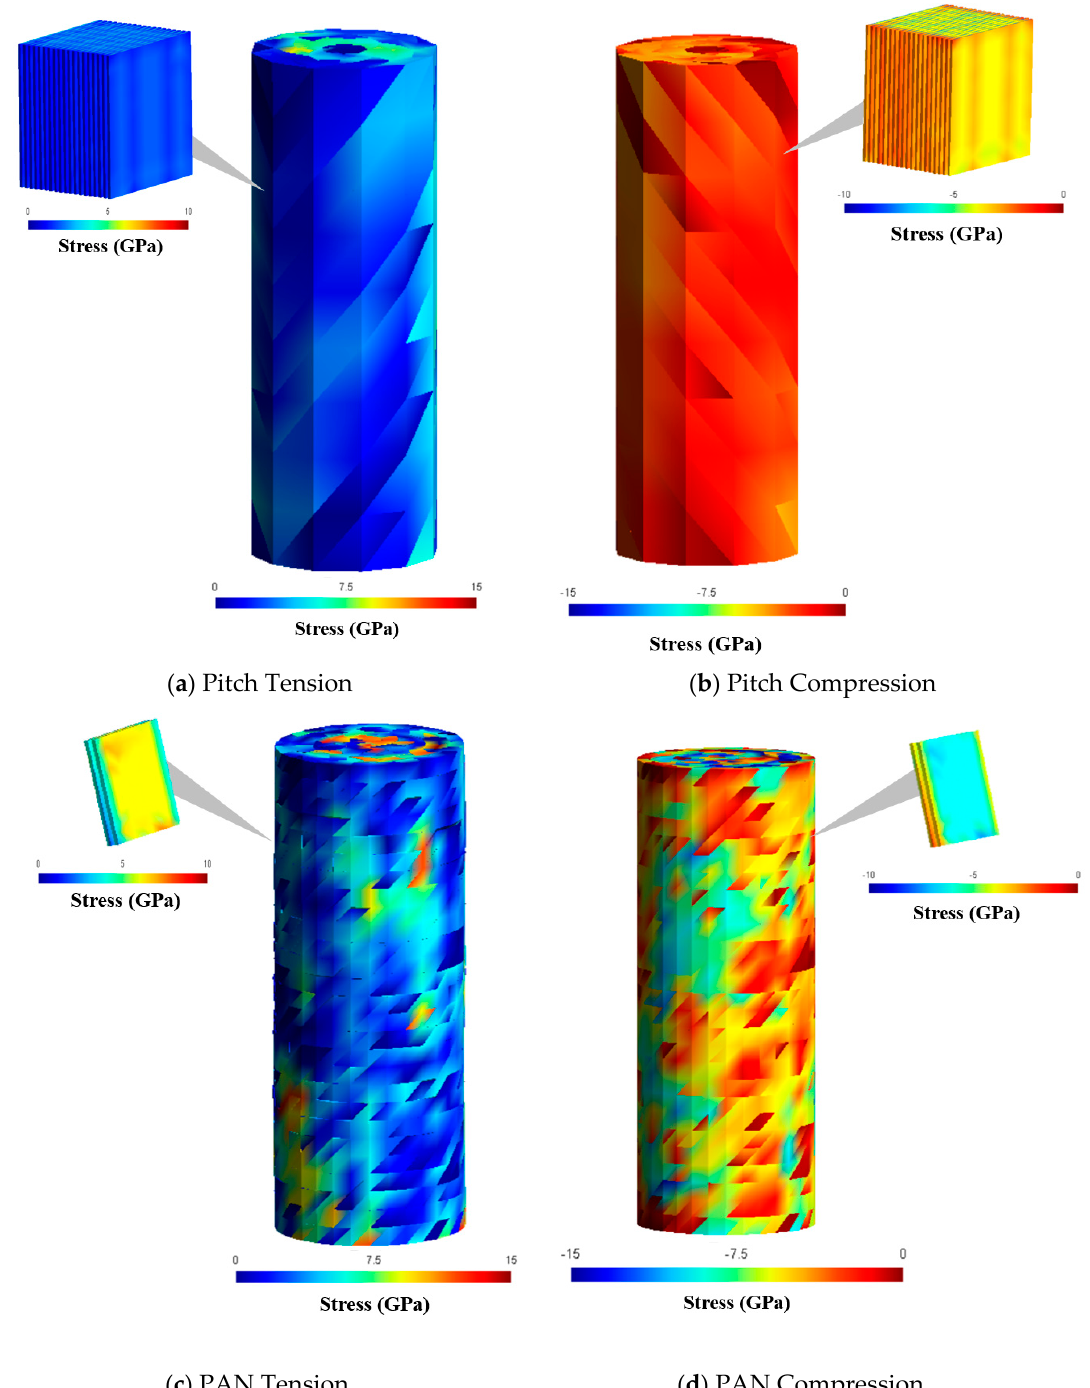
Figure 11. Simulation results for ( a , c ) tensile and ( b , d ) compressive deformation using crack dislocations between multiscale RVEs for ( a , b ) pitch-based carbon fibers and ( c , d ) PAN-based carbon fibers.